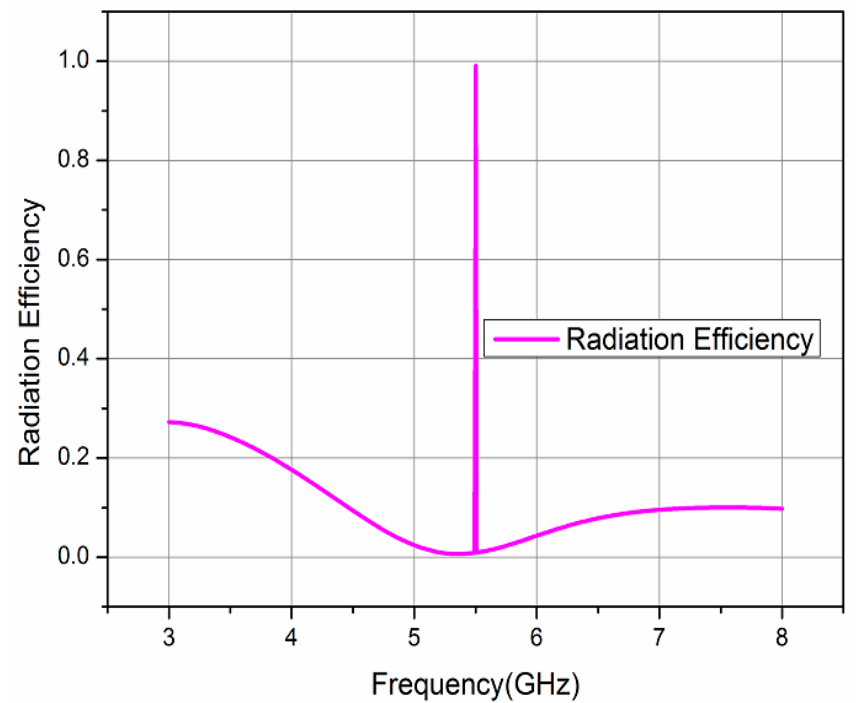
Figure 13. Simulated radiation efficiency.